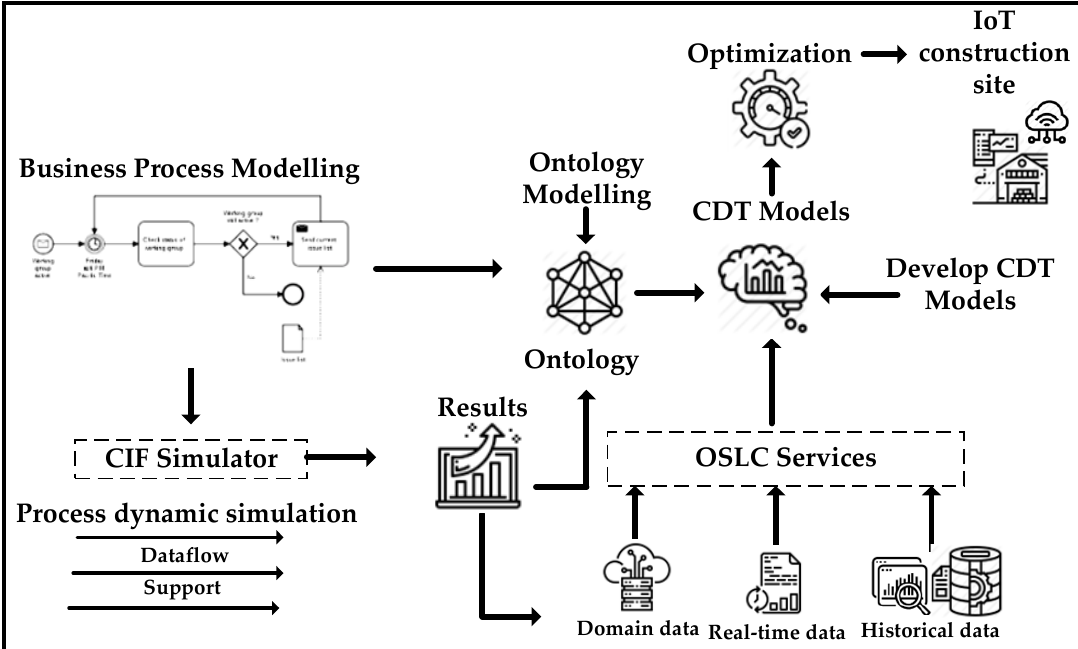
Figure 4. Outline of the process flow of Cognitive Digital Twin for Building Lifecycle Management (CDTsBLM) (adapted from the developed framework by Lu et al.